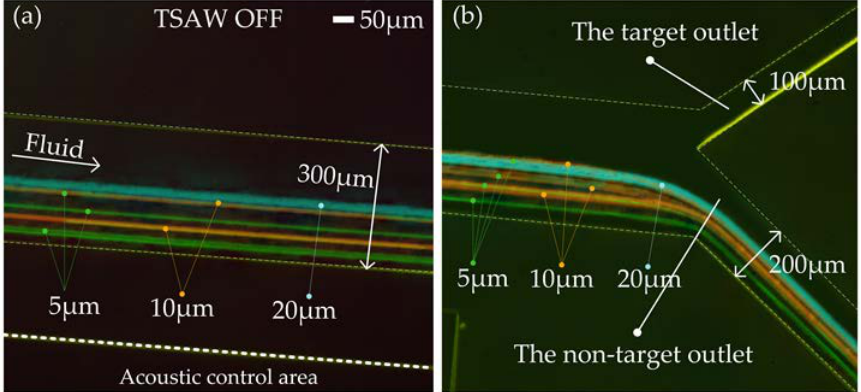
Figure 7. The test effect diagram after superimposing the particle tracks of each particle size: ( a ) Test diagram of the particle tracks in acoustic control area; ( b ) Test diagram of the particle tracks at the outlets of the flow channel.